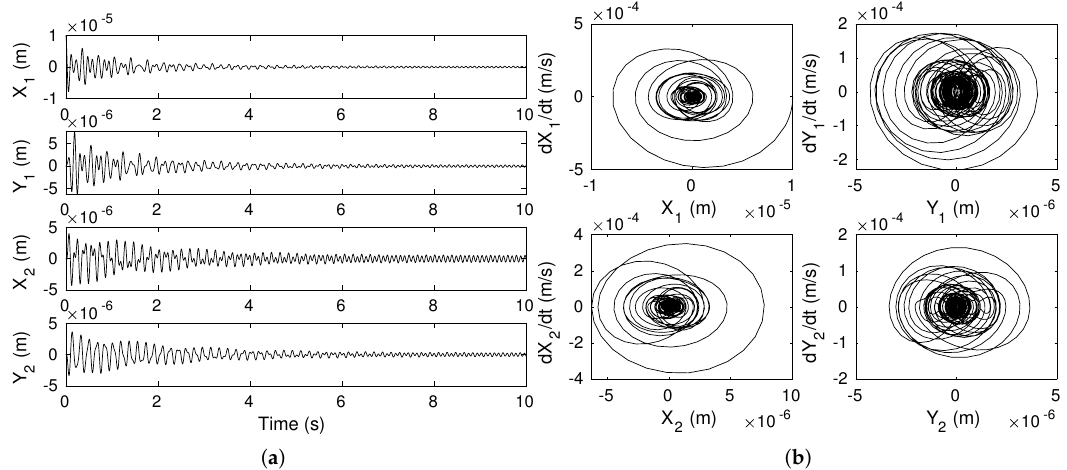
Figure 5. Nonlinear controlled response with γ = − 0.1 and µ = 0.4. ( a ) Displacements. ( b ) Limit cycles.